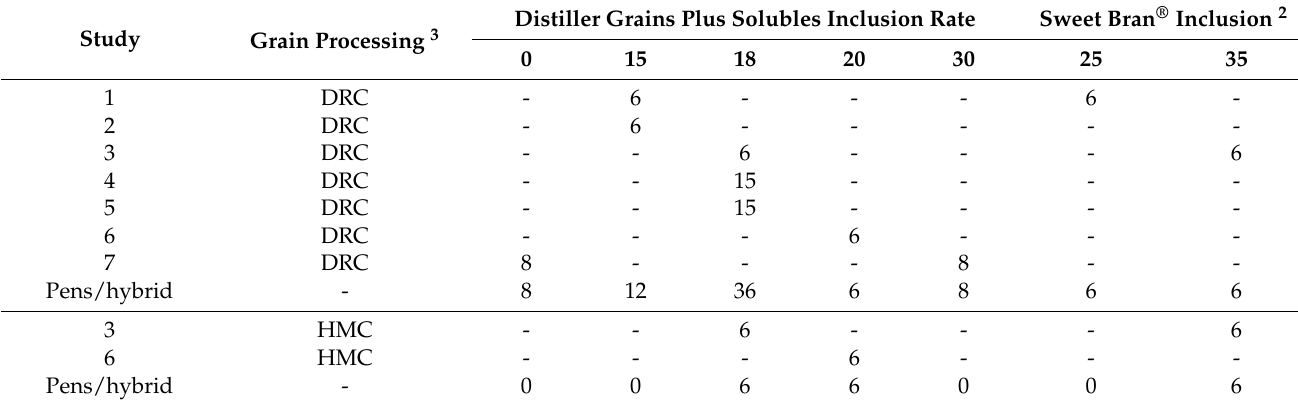
1 Hybrids consisted of Control corn (CON) or Enogen ® Feed Corn (EFC); 2 Different inclusion rates of either distiller grains plus solubles or a branded corn gluten feed (Sweet Bran ® ) were fed in different studies; 3 Corn was processed as either dry-rolled corn (DRC) or high-moisture corn